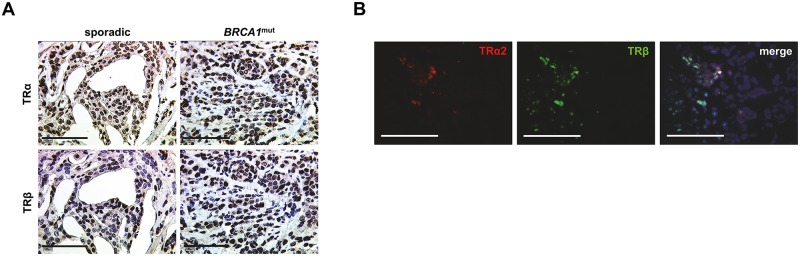
Co-localisation of TRα and TRβ.Co-localisation of TRα and TRβ was observed in some tumor cells as shown by staining serial slides (A) or by co-staining of TRs (TRα2: red signal, TRβ: green signal, DNA: blue signal) by double-immunoflourescence (B). Scale bars represent 100 μm and representative photomicrographs are shown.